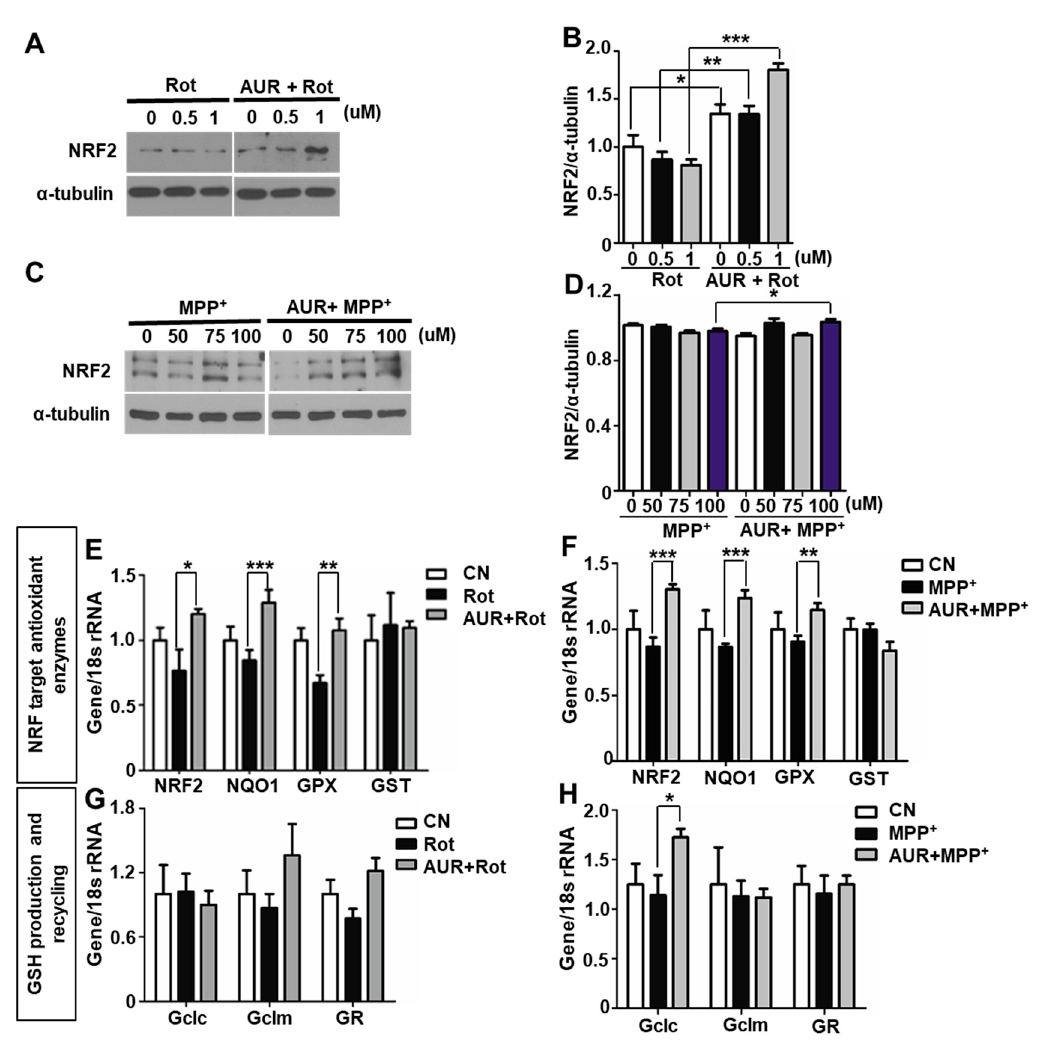
Figure 2. AUR induces expression of genes encoding antioxidant enzymes. ( A – D ) SN4741 cells were incubated in media containing different concentrations (0, 0.5 or 1 μ M) of rotenone (Rot) or MPP + (0, 50, 75 or 100 μ M), with or without pretreatment for 1 h with 10 μ M AUR or DMSO. NRF2 protein expression was determined by Western blotting after 24 h ( A ) or 6 h ( C ) of drug treatment. The band intensity of NRF2 was measured using the ImageJ program ( B , D ). ( E – H ) Expression of mRNA for NRF2 target antioxidant enzymes ( E , F ) and GSH recycling-related genes ( G , H ) were assessed after a 24 h drug treatment using qPCR. Values are presented as means ± SD (bars) of triplicate samples (* P < 0.05, ** P < 0.01, *** P < 0.001 vs. corresponding